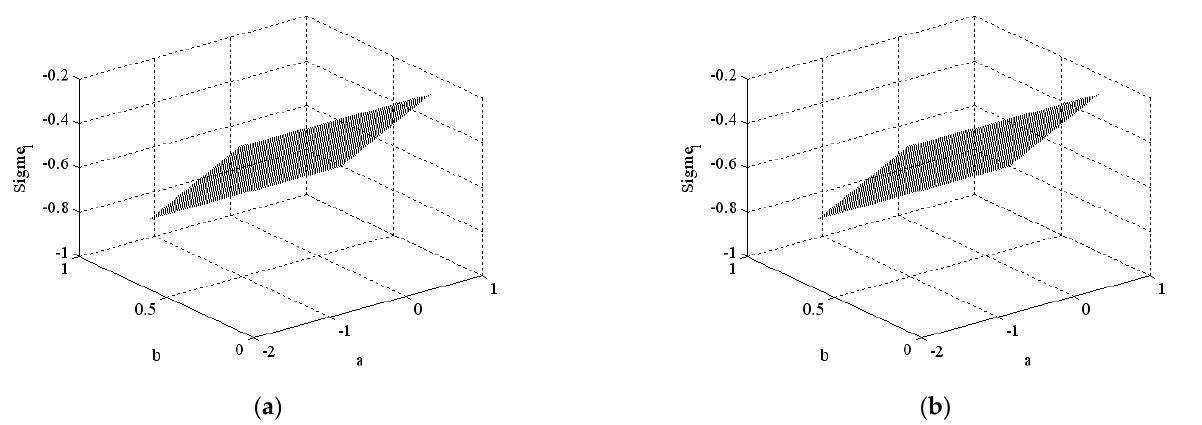
Figure A1. Results for σ 1 of fixed point O 1 ( a ) and fixed point O 2 ( b ), as functions of control (bifurcation) parameters a ∈ [ − 1.51,1 ] and b ∈ [ 0.29,0.8 ] . According to TheoremA1 (see Appendix B), the system has an infinite number of period-doubling bifurcations. Note that some of these bifurcations are related to a “basic” limit cycle.